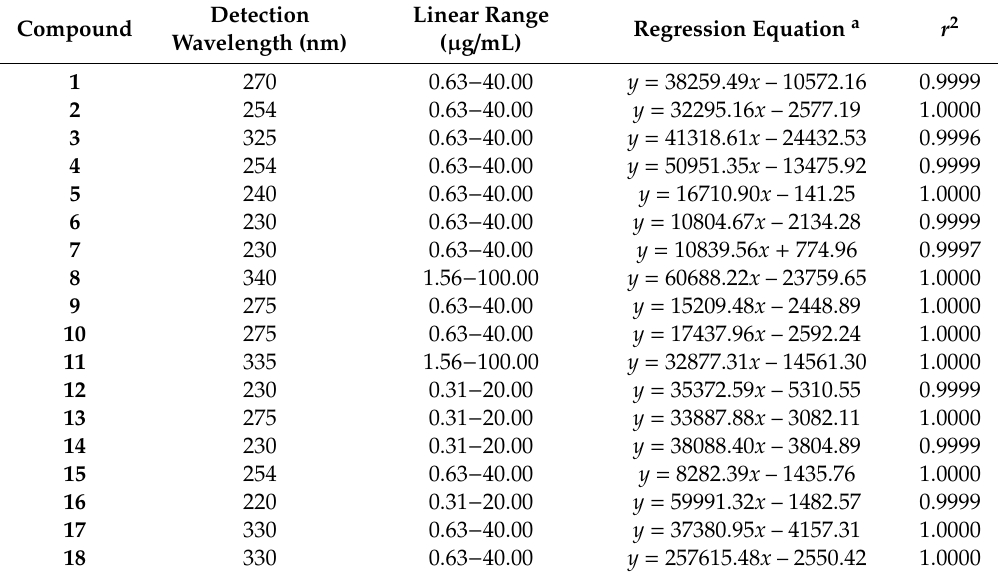
(Table 3). By using optimized chromatography, representative chromatograms of the Gami-soyosan sample and standard compounds were obtained (in Figure 2). The concentrations of compounds 1 – 18 were in the range of 0.04 to 8.73 mg / g (Table 4). Table 3. Detection wavelength, range, regression equation, and coe ffi cient of determination ( r 2 ) of compounds 1 – 18 .